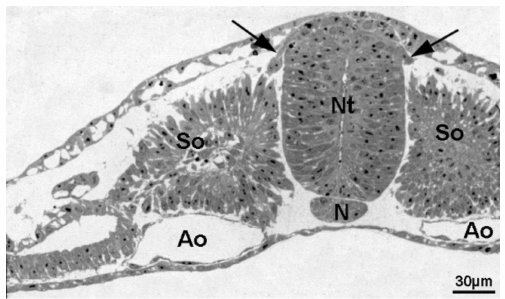
Figure 1. Transverse section of a chick day-2 embryo showing migration of neural crest cells